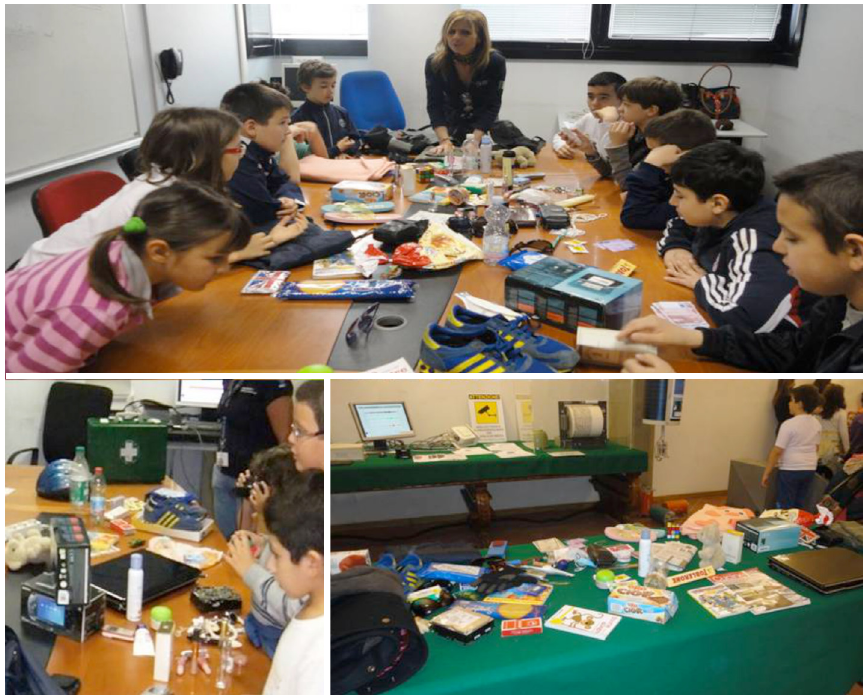
Figure 5. Laboratory activities of “Scientists as a game”: What should I do and what should I take with me in the case of an earthquake? The children have to pick the objects that might be useful in an emer- gency pack in the case of an